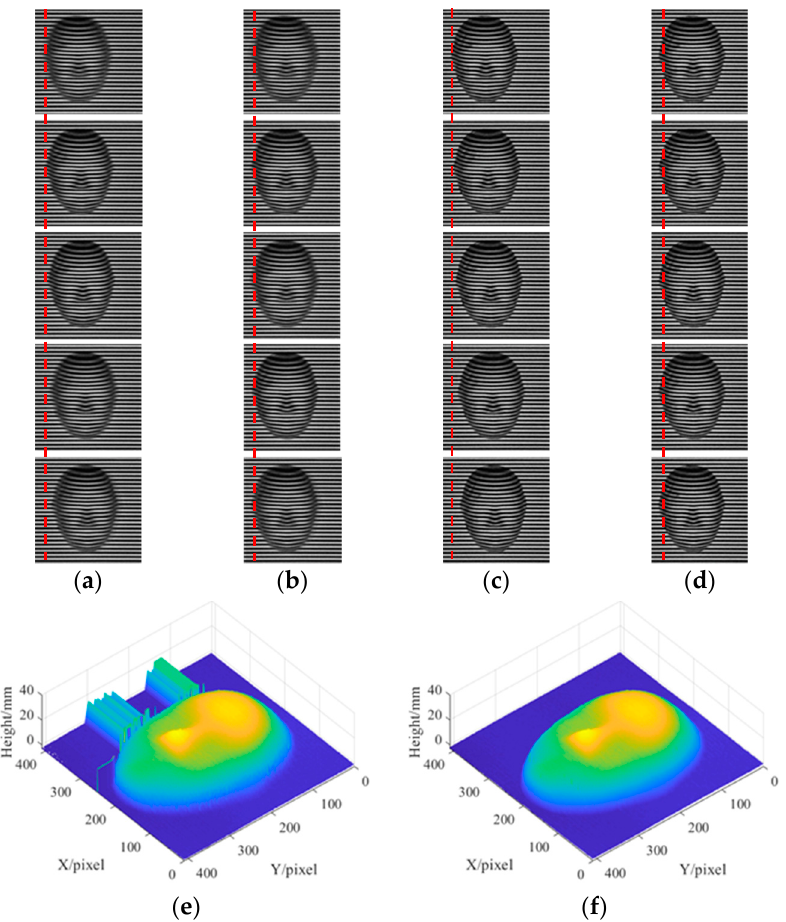
Figure 6. Experimental results for “face” model, pixel size of Figure 6a,c is 512 × 512, pixel size of Figure 6b,d is 458 × 512: ( a ) High-resolution deformed patterns by averaging; ( b ) Equivalent deformed patterns by averaging; ( c ) High-resolution deformed patterns by the proposed method; ( d ) Equivalent deformed patterns by the proposed method; ( e ) Object reconstruction by averaging; ( f ) Object reconstruction by the proposed method.